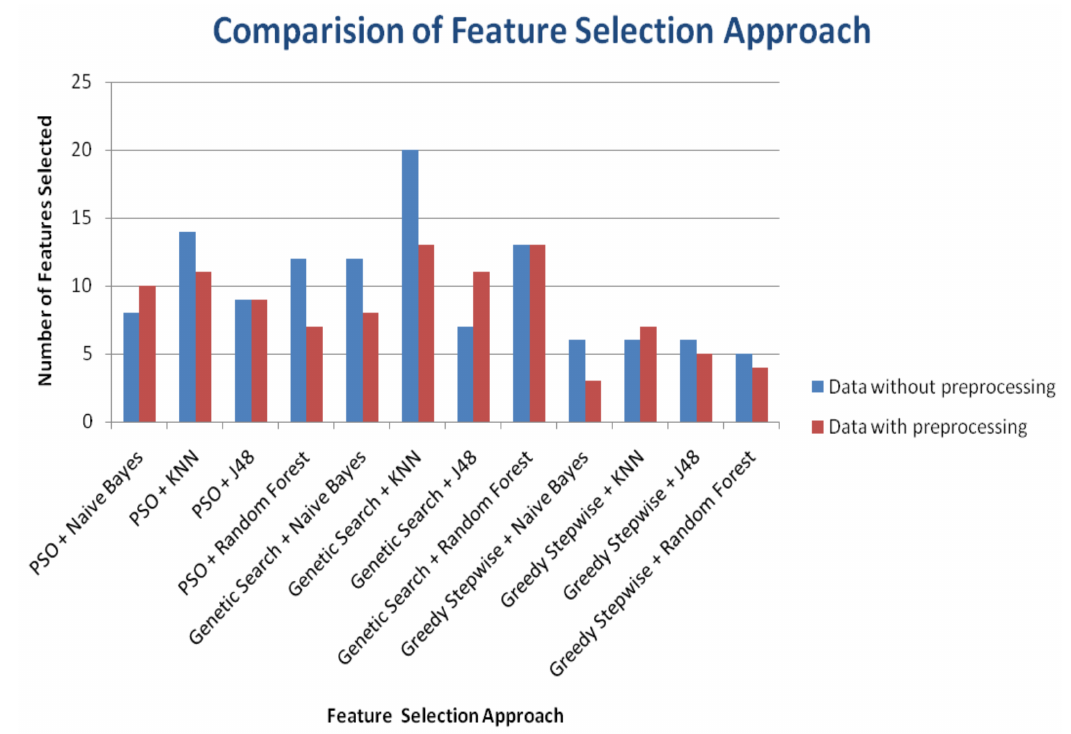
Figure 3. Comparison of the number of features